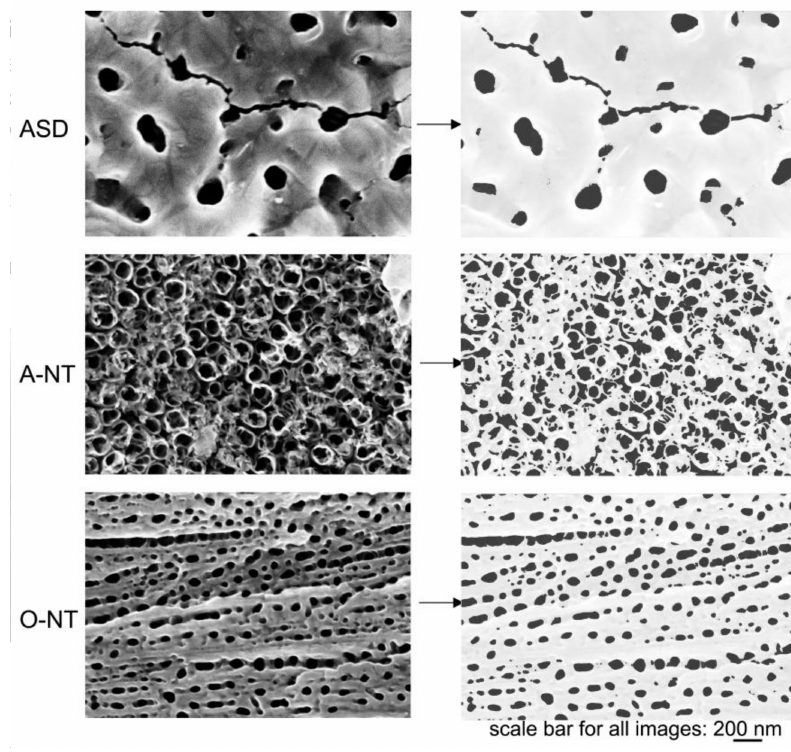
Figure 5. Topography of samples and highlight of open porosities.